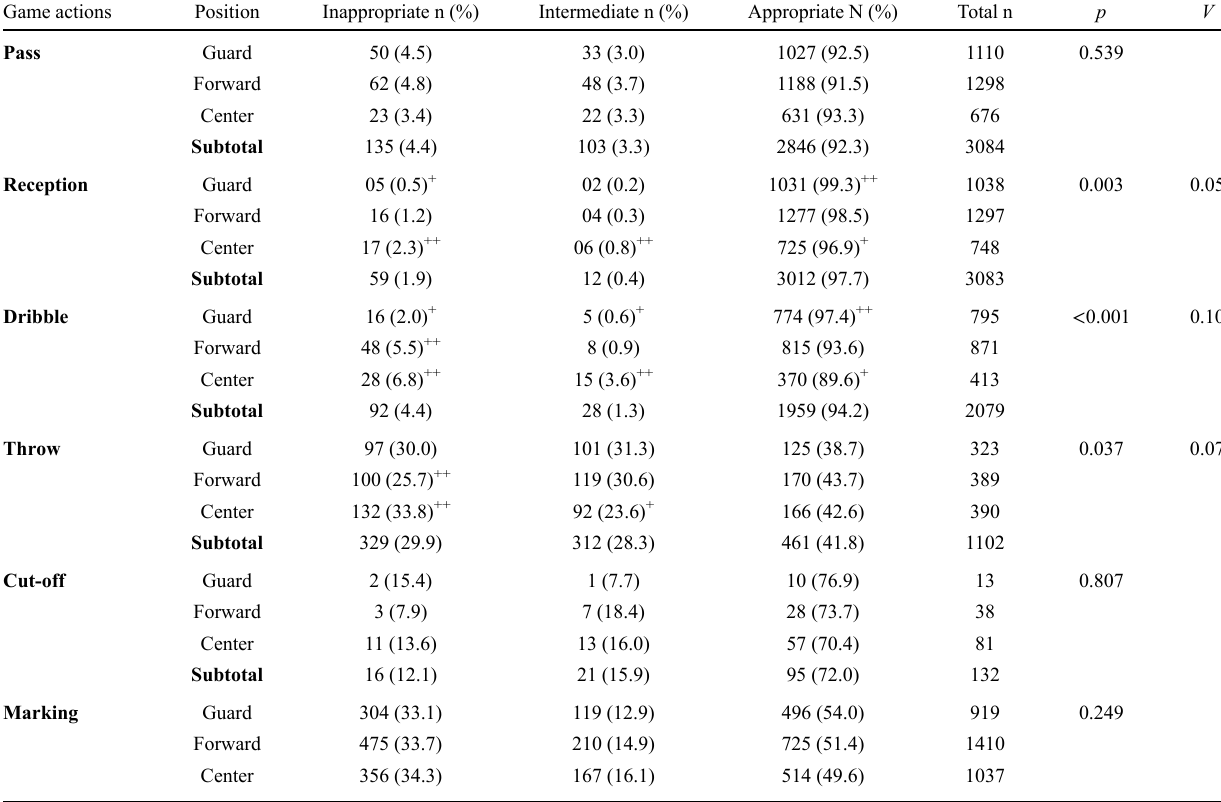
Table 1 - Overall performance level in game actions, considering the positions of the players. Game